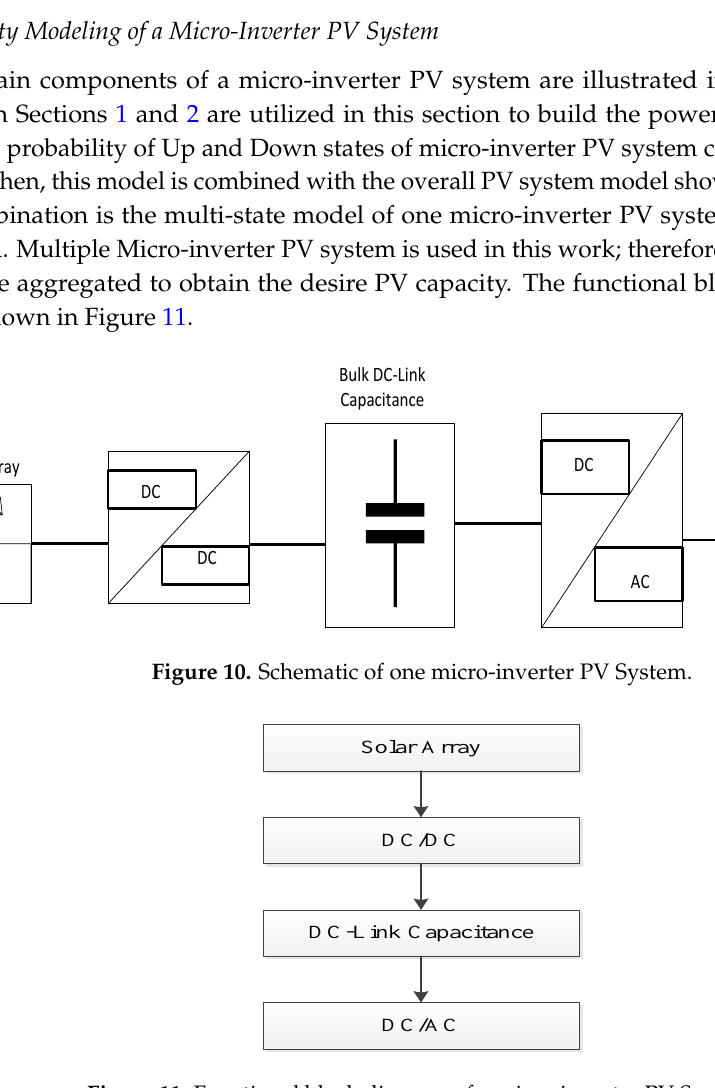
Figure 11. Functional block diagram of a micro-inverter PV System. Table 5. Two states model of micro-inverter PV system components.